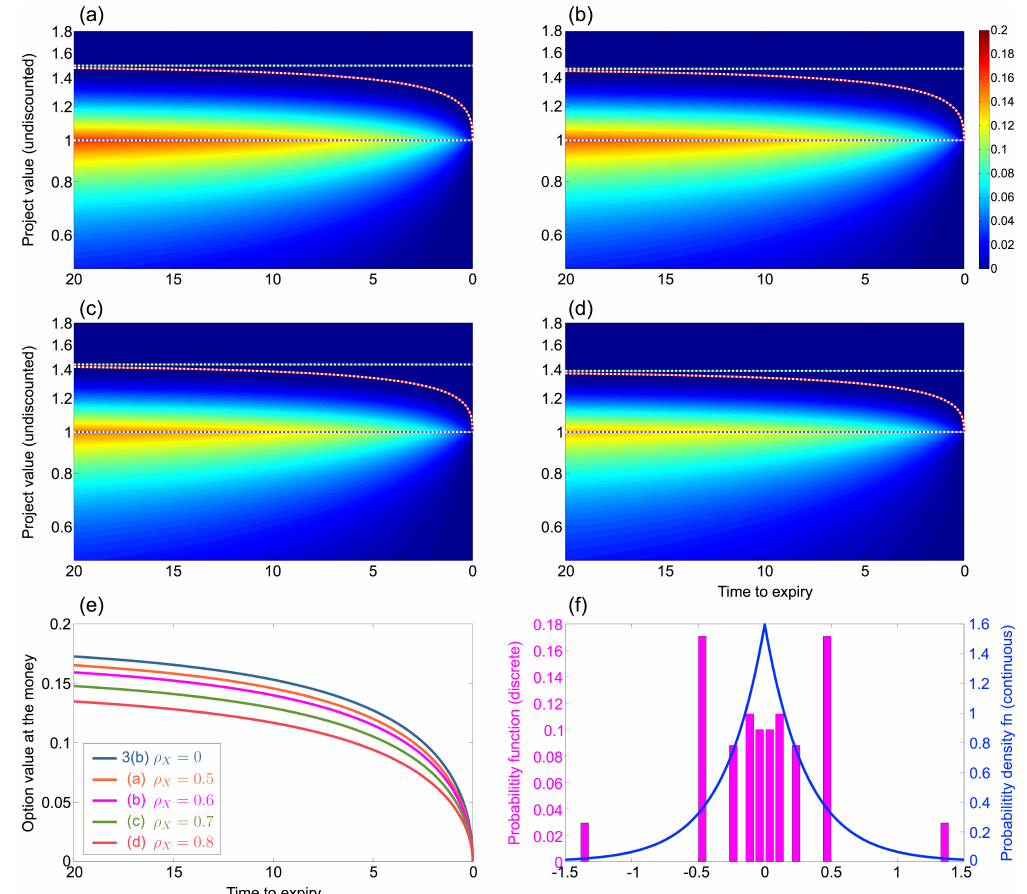
Figure 4. Process as in Figure 3b, but incorporating jump diffusion with parameters λ = 0.1, χ = 1. The parameter ρ X is, sequentially: ( a ) 0.5; ( b ) 0.6; ( c ) 0.7; ( d ) 0.8. Sub-figure ( e ) Plot of undiscounted option value at the money, versus time to expiry, for the four cases represented in ( a – d ). Sub-figure ( f ) Continuous and discrete (incorporating rounding of the x i values) approximations of the random variable σ 2 ρ X ∆ X , for the case ρ X = 0.6. Exercise threshold at t = 0: ( a ) 1.4736; ( b ) 1.4483; ( c ) 1.4105; ( d ) 1.3563. Option value at the money ( t = 0): ( a ) 0.1653; ( b ) 0.1588 ( c ) 0.1490; ( d ) 0.1348. Calculation times (backwards induction step): ( a ) 4.07 s (1.3 × ); ( b ) 4.48 s (1.4 × ) ; ( c ) 4.98 s (1.6 × ); ( d ) 6.14 s (1.9 × ), where